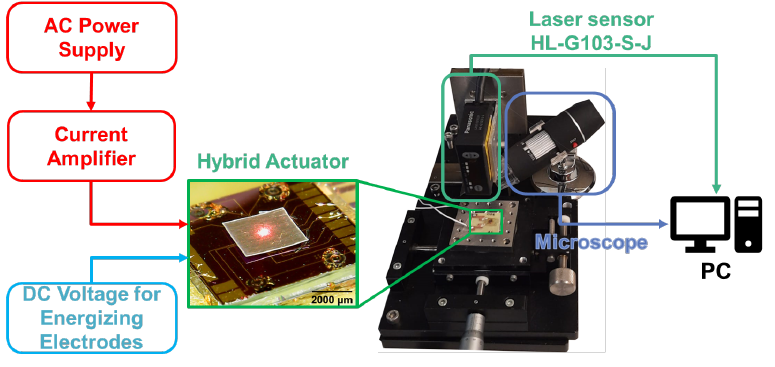
Figure 2. Experiment